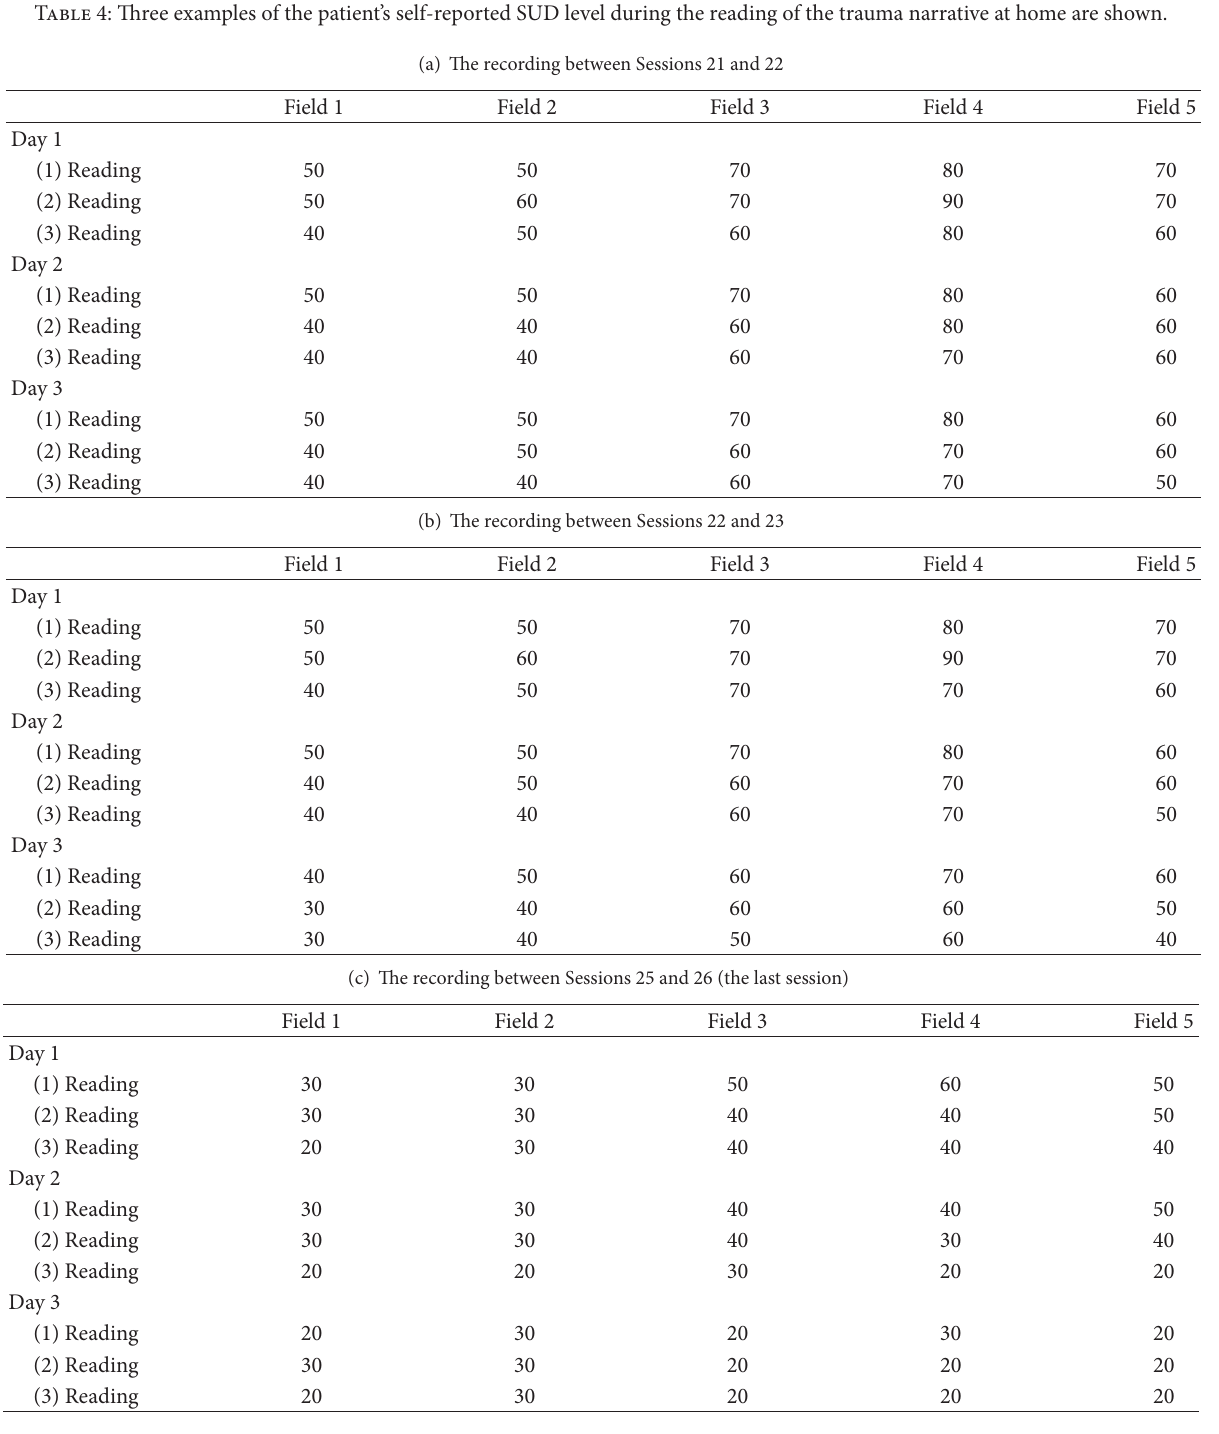
T 4: ree examples of the patient’s self-reported SUD level during the reading of the trauma narrative at home are